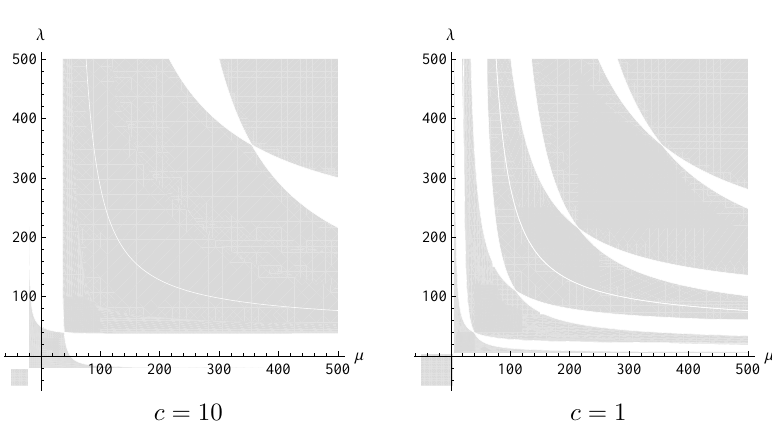
Figure 8. The solvability regions for c >